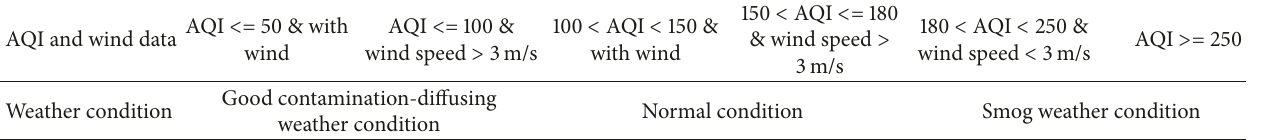
Table 1: Weather condition mode